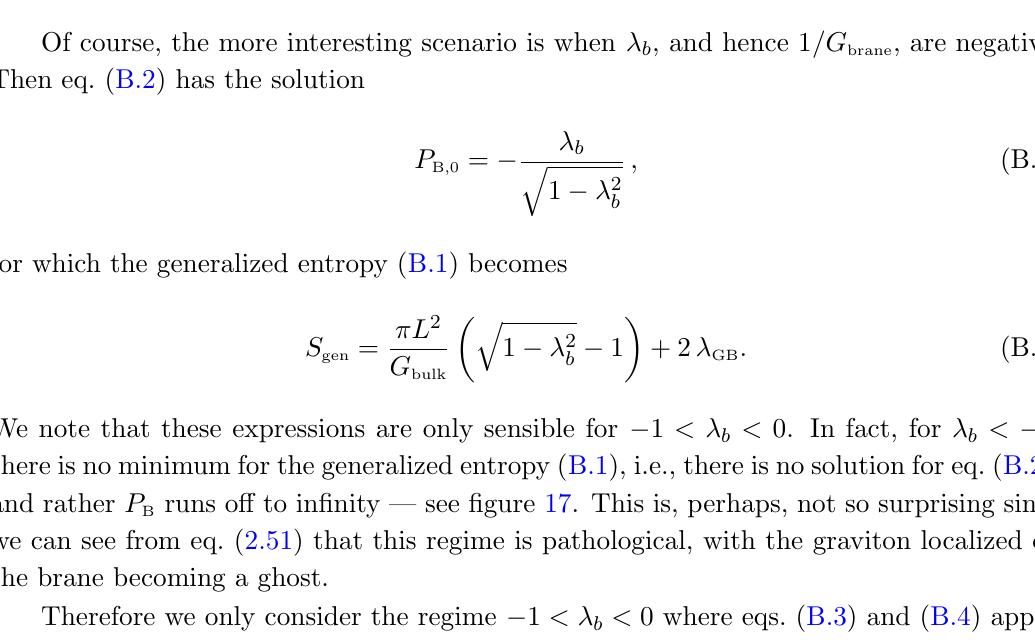
Figure 17 . The generalised area (B.1) for a bubble as a function of its radius. For (cid:21) b > 0, the area is minimal for vanishing size, whereas for (cid:0) 1 < (cid:21) b < 0 it has a (cid:12)nite size. For (cid:21) b < (cid:0) 1, there is no global minimum, signalling an instability of the system. Further note that as P 0 approaches zero, S ! (cid:25)L 2 =G since we have set (cid:21) = (cid:25)L 2 = (2 G gen bulk GB bulk